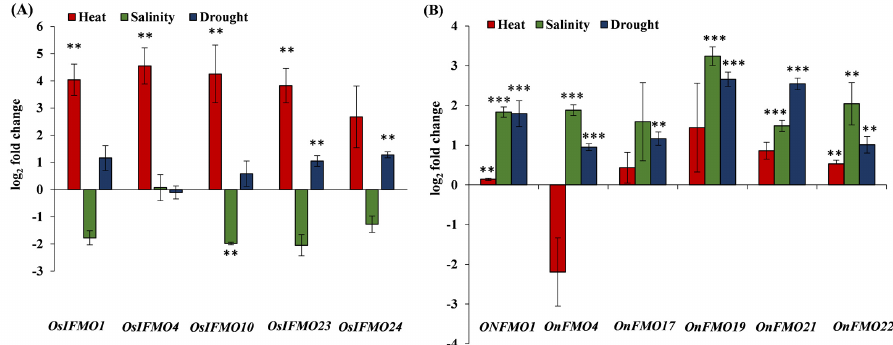
Figure 8. Real-Time expression analysis of FMO genes in wild and cultivated rice . Expression profiling of selected FMO members from one month old leaves of ( A ) Oryza sativa subsp. indica (PB1 variety) and ( B ) Oryza nivara using qRT-PCR in response to heat stress (42 °C), salinity stress (200 mM NaCl) and drought stress (water withheld) for 24 h . Mean fold change (log 2 ) is depicted, and the expression data is plotted against the untreated samples. The error bar represents the standard deviation where n = 6. *** signifies p value < 0.05 upto four or more decimal places and ** signifies p value < 0.05 for two decimal places.